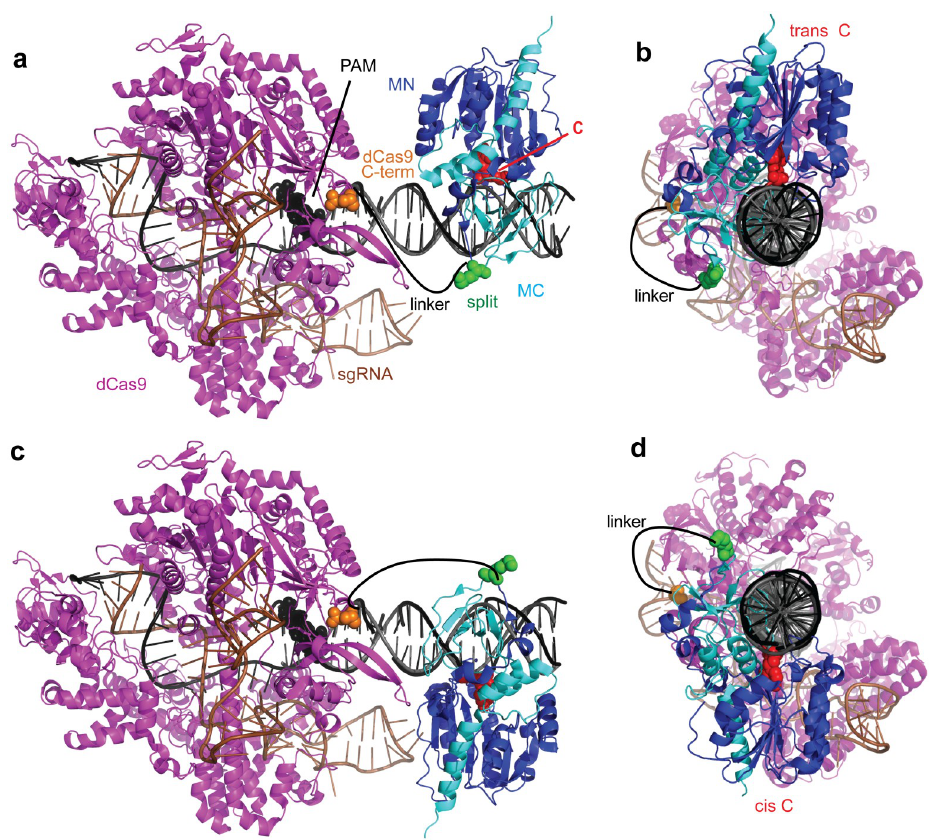
Fig 2. Structural models of dCas9 and M.SssI bound to the same DNA. The model shows a gap length of 11 nucleotides between the PAM and the target CpG site. Models were built by superimposing the crystal structure of DNA-bound S . pyogenes dCas9 (4UN3) [24] and the M.SssI homolog M.HhaI (2HR1) [25] onto the same molecule of B-DNA. (a) Front view and (b) side view of M.HhaI bound on the trans strand 11 base pairs from the PAM. (c) Front view and (d) side view of M.HhaI bound on the cis strand 11 base pairs from the PAM. A hand-drawn line represents the linker between the C-terminus of dCas9 and the N-terminus of MC. Figure adapted from Xiong et al.